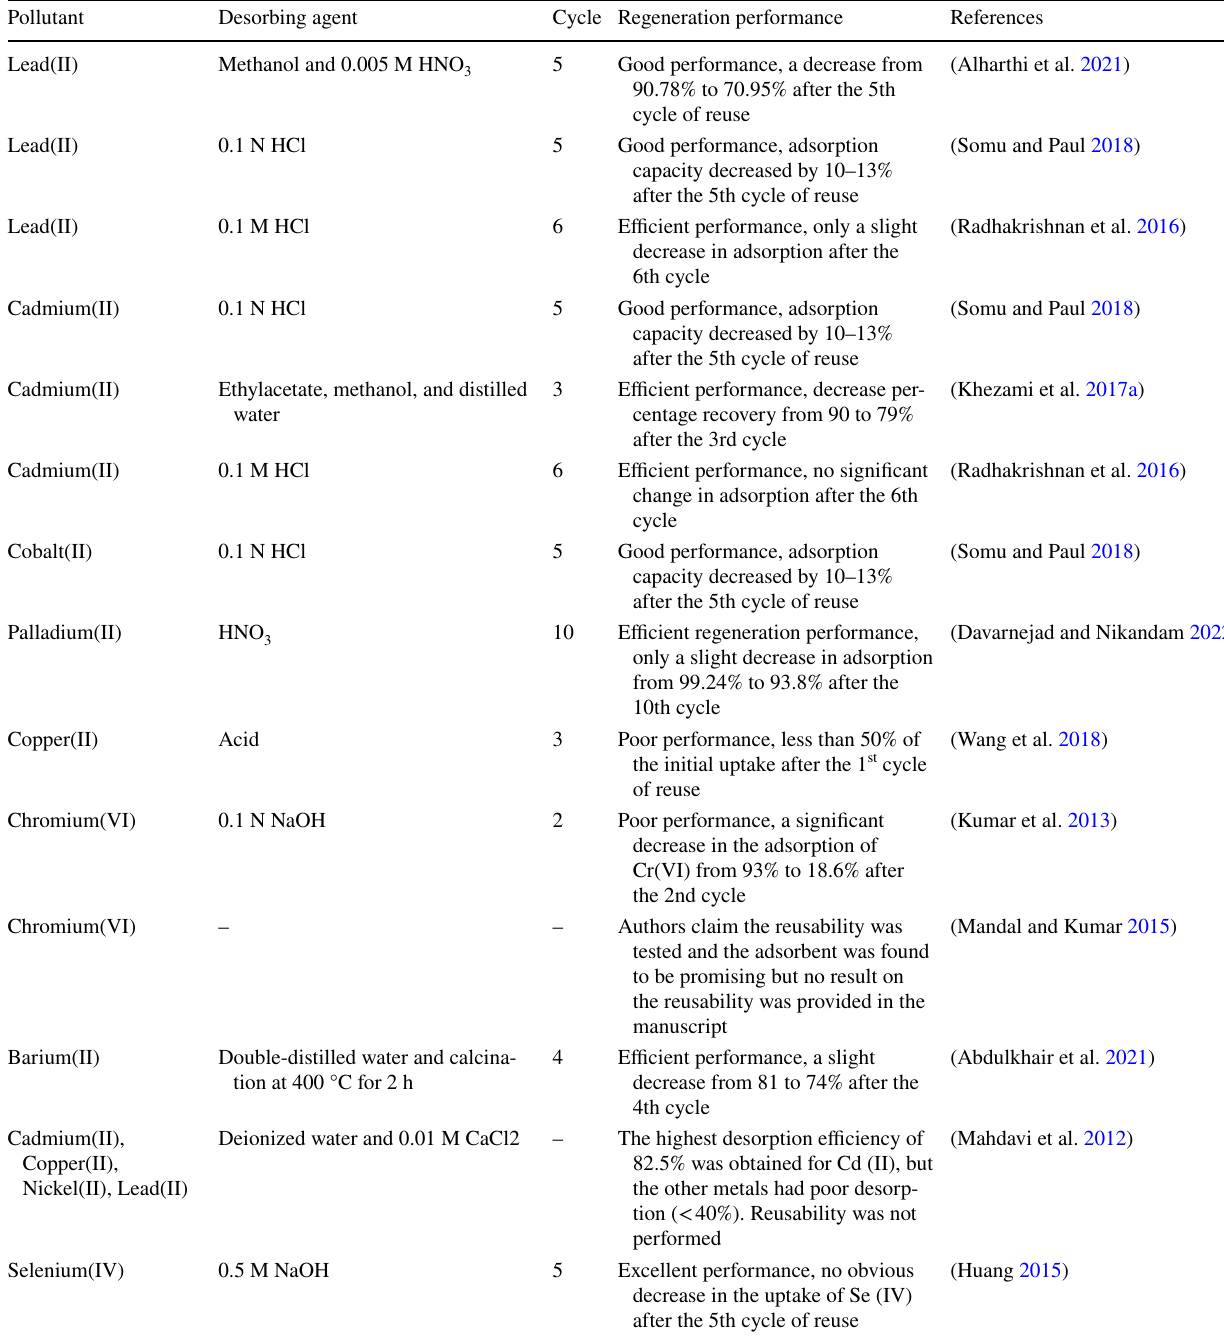
Table 6 The reusability of ZnO nanoparticles in the adsorption of heavy metals and radionuclides